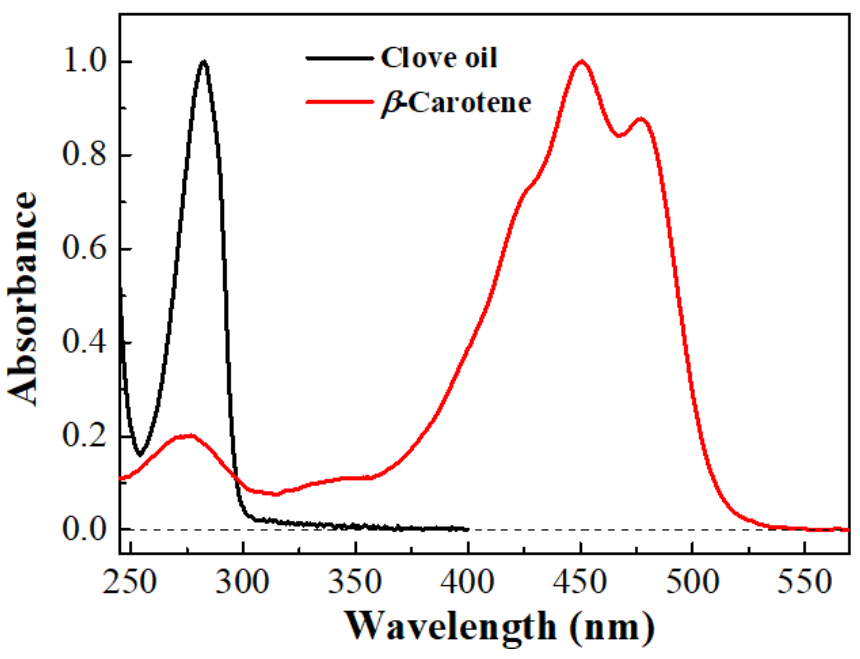
Figure 3. Absorption spectra of β -Car in methanol normalized at 450 nm and of clove oil in methanol normalized at 283 nm.